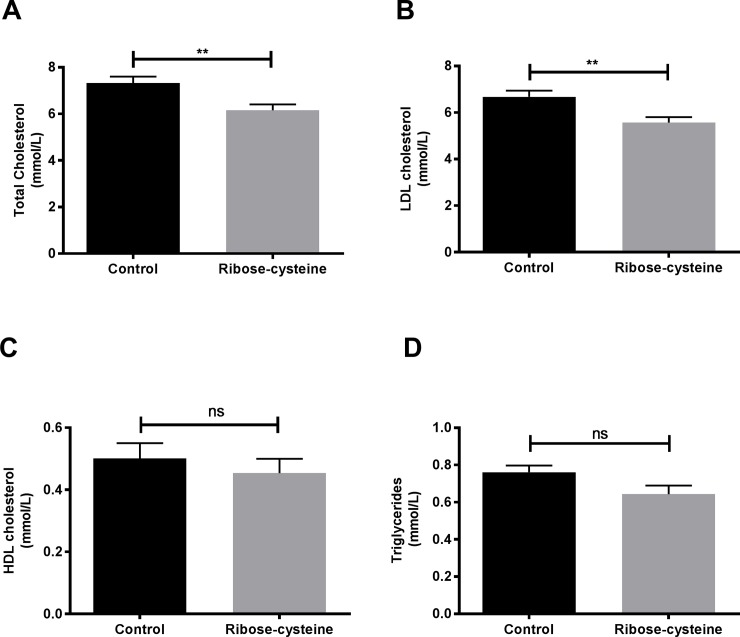
Ribose-cysteine decreases total plasma and LDL cholesterol in apoE-/-mice.Total plasma cholesterol, HDL cholesterol and triglyceride levels were measured in ribose-cysteine treated and control apoE-/- mice (n = 15 per group) by enzymatic assay. LDL cholesterol levels were calculated by the Friedewald equation. (A) Total cholesterol, (B) LDL cholesterol, (C) HDL cholesterol, (D) Triglycerides. ** p < 0.005. Error bars indicate means ± SEM.